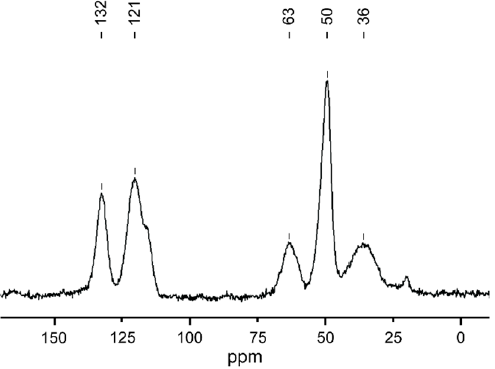
Figure 1. CP-MAS-TOSS 13 C-NMR solid state of material HP.